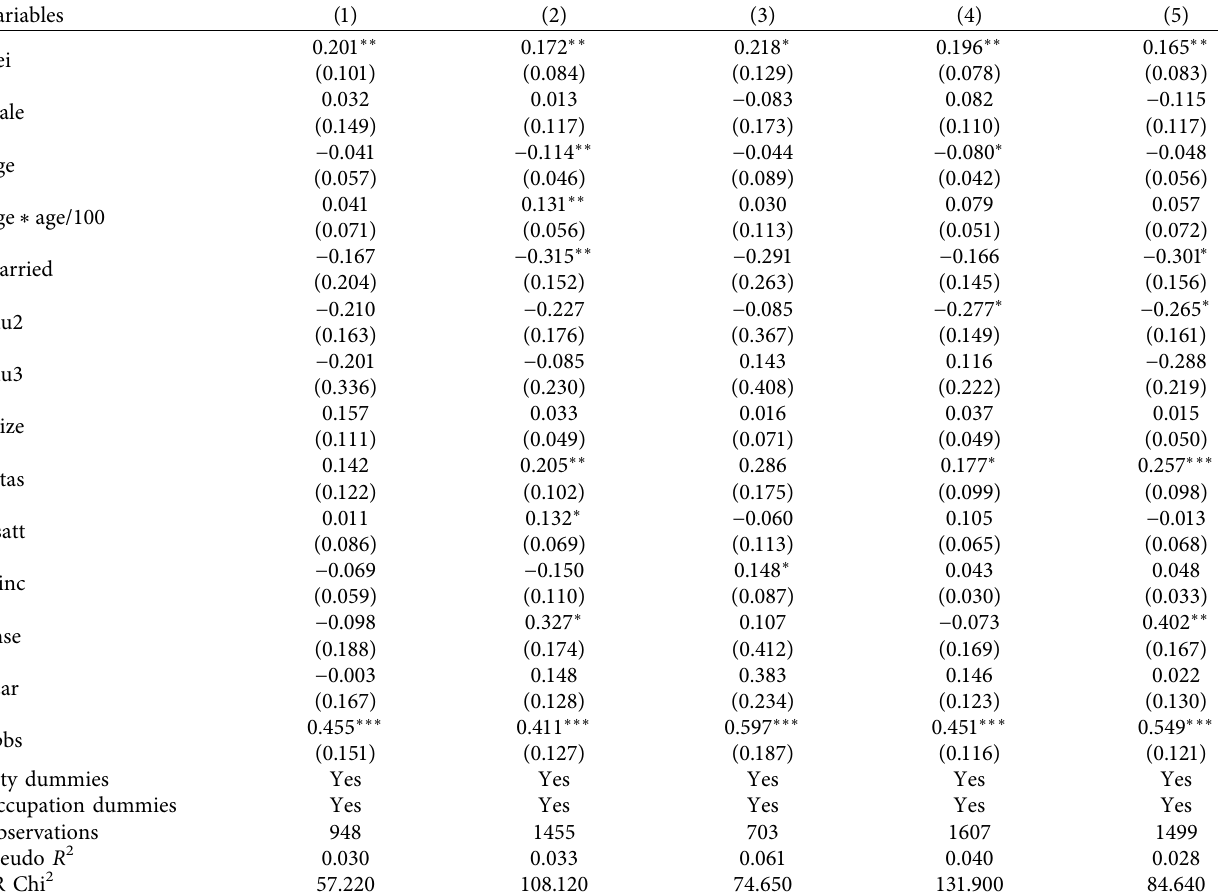
Table 9: Results of the heterogeneity